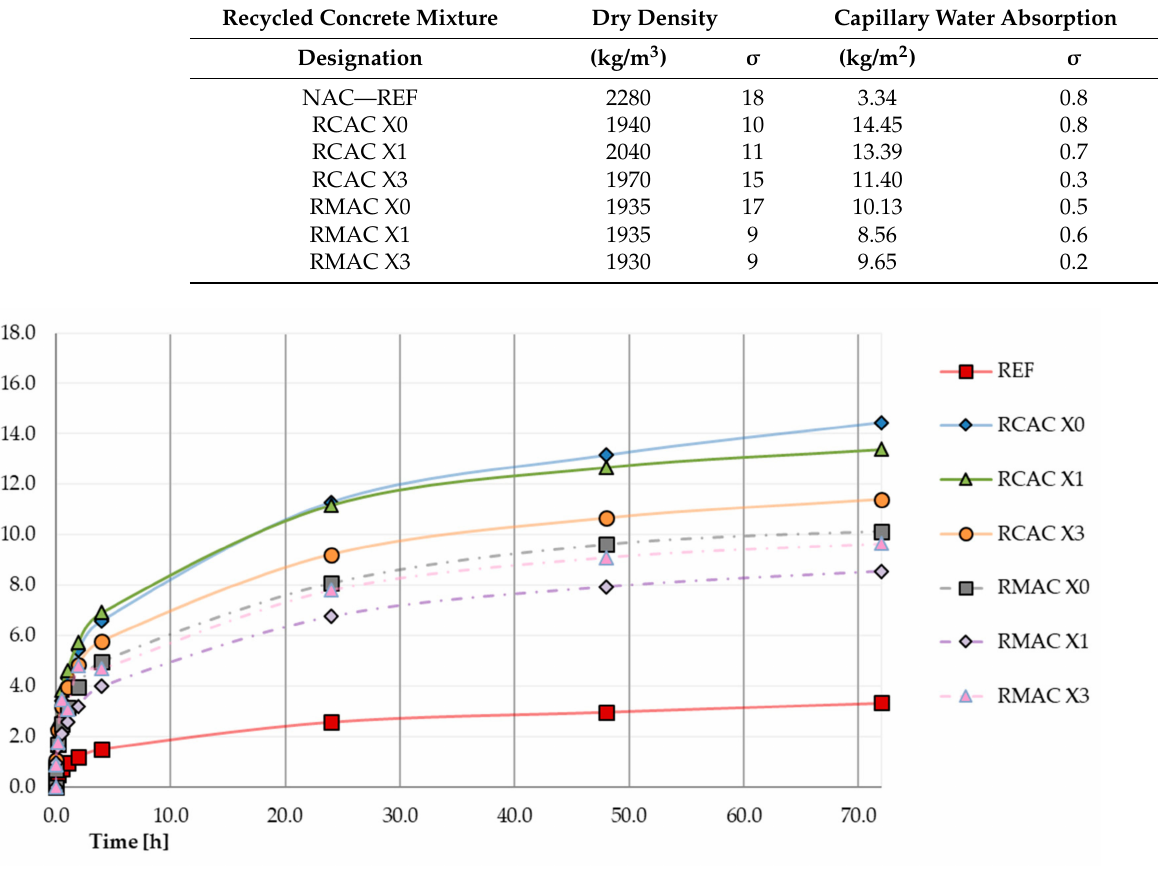
Figure 4. Comparison and progression of capillary water absorption of NAC, RCAC, and